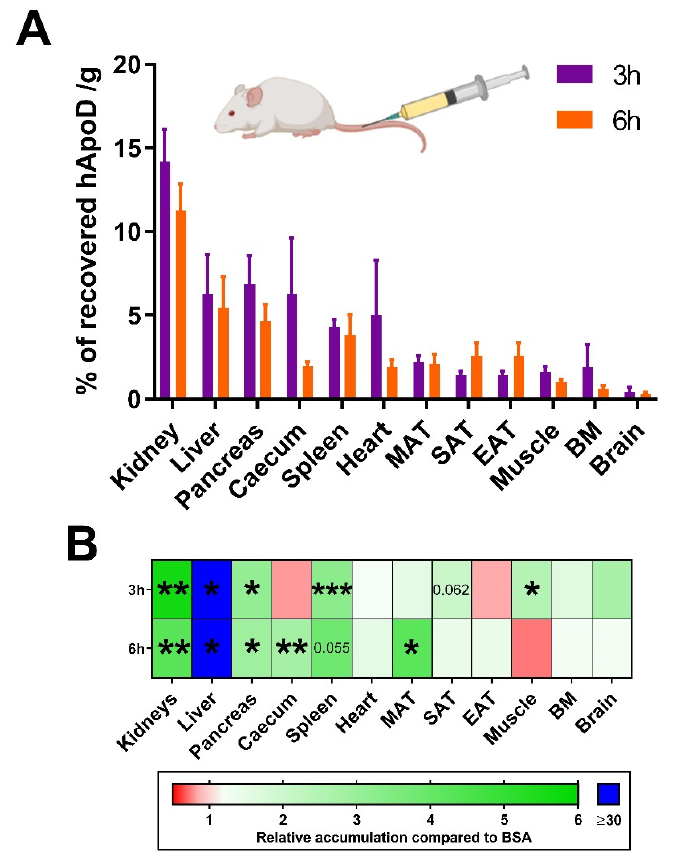
Figure 2. Circulating hApoD accumulates in specific peripheral organs. Radiolabeled proteins (Bovine Serum Albumin (BSA) and hApoD) were injected intravenously in mice. Blood, urine, and—after perfusion—organs were collected 3 and 6 h post-injection. ( A ) Results are presented as the percentage of radioactivity recovered per gram of tissues. EAT: epididymal adipose tissue, SAT: subcutaneous adipose tissue, MAT: mesenteric adipose tissue, and BM: bone marrow. ( B ) The heat map shows the accumulation of hApoD relative to albumin. Statistical significance was evaluated via a Student t -test: * p < 0.05, ** p < 0.01, *** p < 0.001 (n = 4